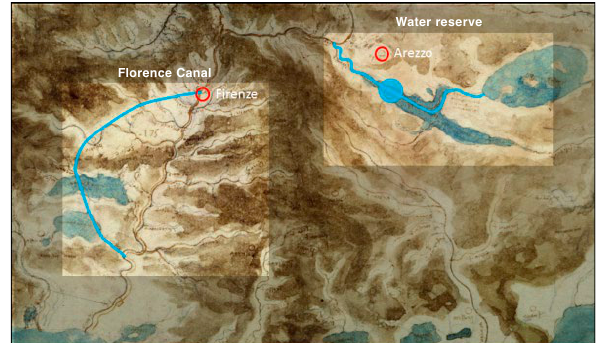
Figure 7. Scheme of Leonardo’s hydrographic project (traced on the Map of Tuscany , Windsor, Royal Library,